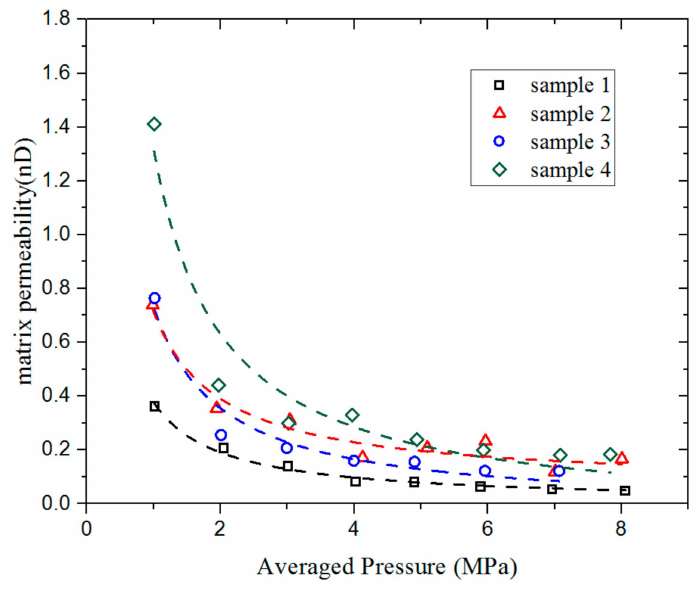
Figure 8. Matrix permeability of four shale particle samples under di ff erent pressures. The dotted line is the result of the fitting by the Klinkenberg